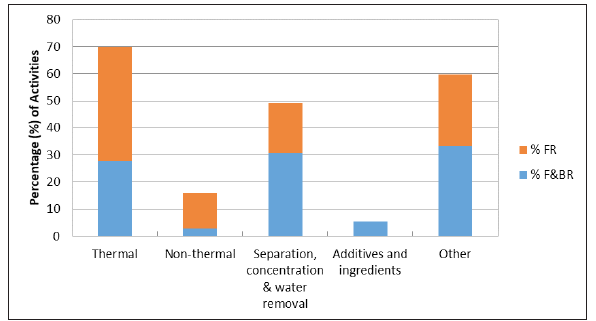
Figure 6: Scientific and technological advances by processing types from Food & Beverage Reporter (F&BR) and South African Food Review (FR) data.